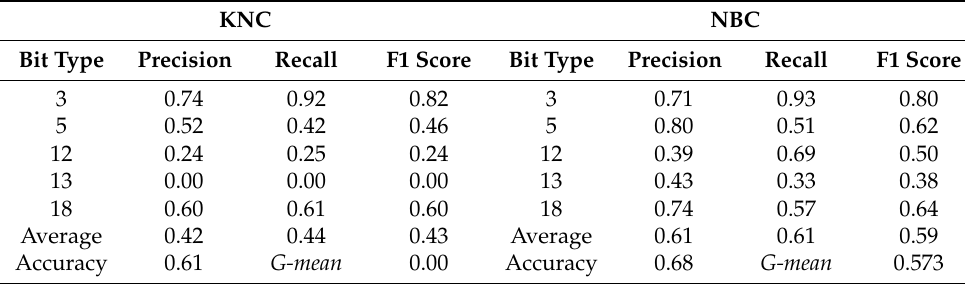
Table 14. The selection of 8.5” drill bits through KNC and NBC